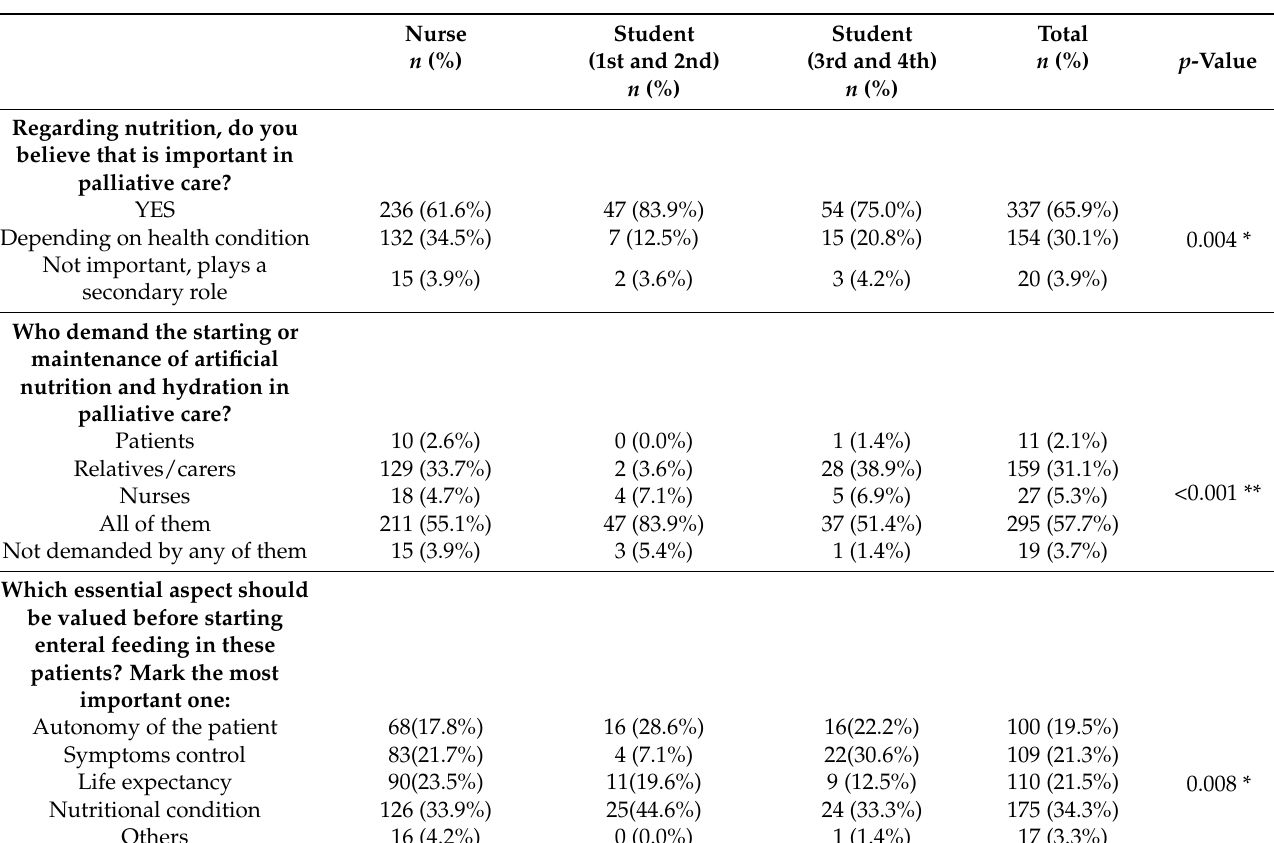
Table 2. Distribution of responses to the